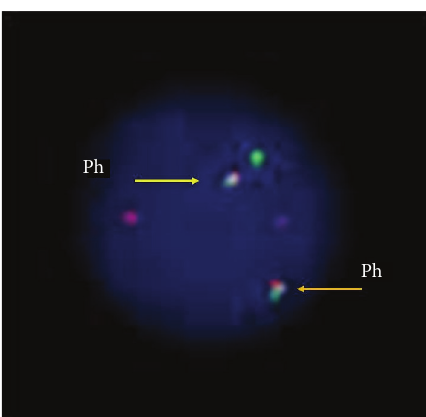
Figure 2: An interphase cell having a secondary Philadelphia chromosome detected in